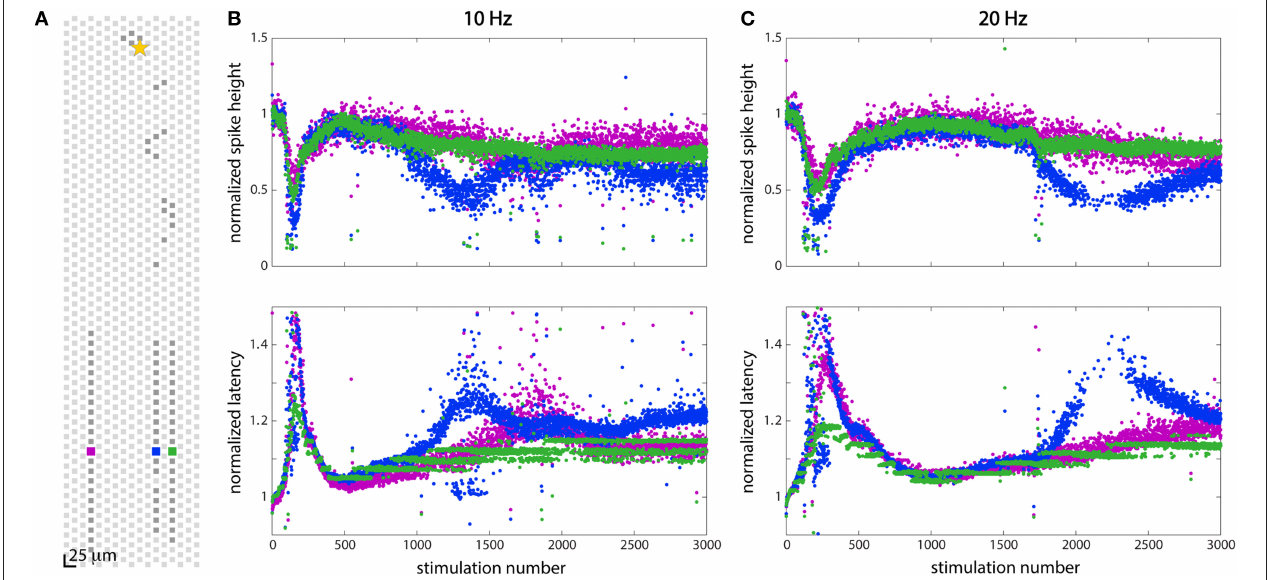
FIGURE 6 | Stimulation at 10Hz and 20Hz showed different effects in two axonal branches. (A) Position of electrodes in three channels from which spikes were recorded. (B) Responses to stimulation at 10Hz at the three electrodes shown in (A) . (C) Responses to stimulation at 20Hz at the three electrodes shown in (A) . At both 10 and 20Hz, all three axonal branches showed slightly different responses to stimulation, although the blue branch showed the most dramatic effects. All three branches display the same adaptation characteristics following 150 (at 10Hz) or 200 (at 20Hz) stimulations, but additional changes in the wave forms are seen in some branches while not in